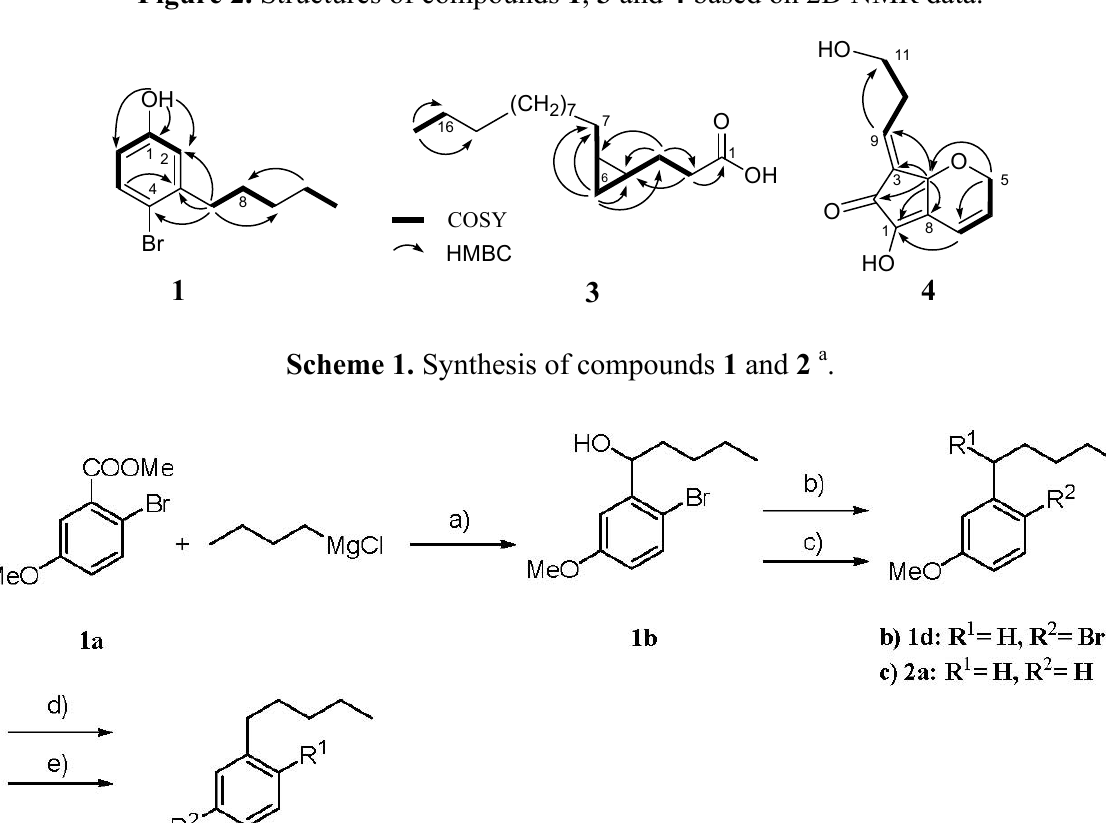
Figure 2. Structures of compounds 1 , 3 and 4 based on 2D NMR data.